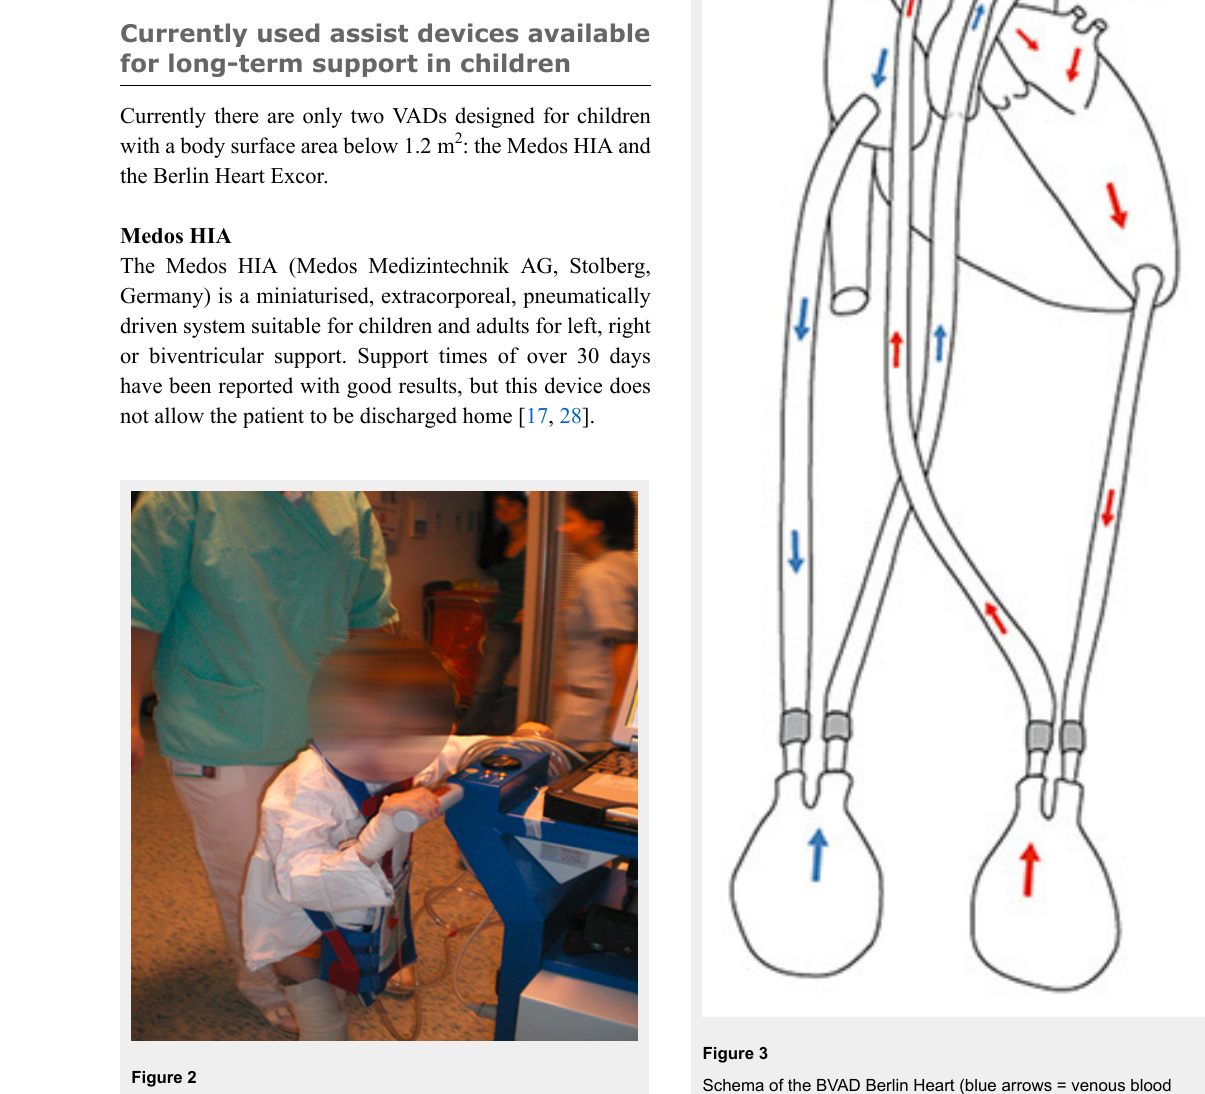
The Berlin Heart Excor is suitable for children of all sizes and with biventricular failure.